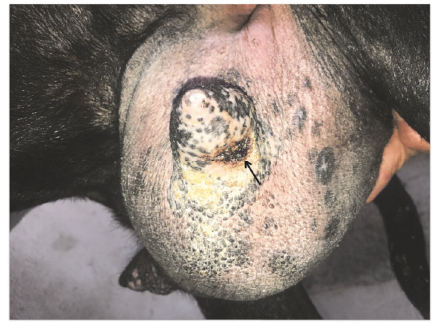
Figure 3: (a) Udder lesions (arrow) on the patient’s goat.